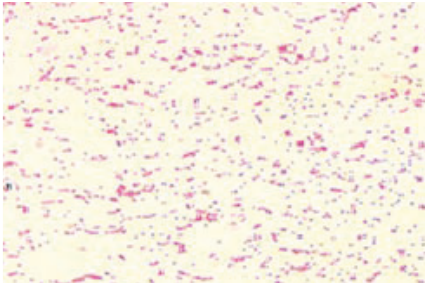
Figure 4: Gram-negative paired coccobacilli under a light micro- scope